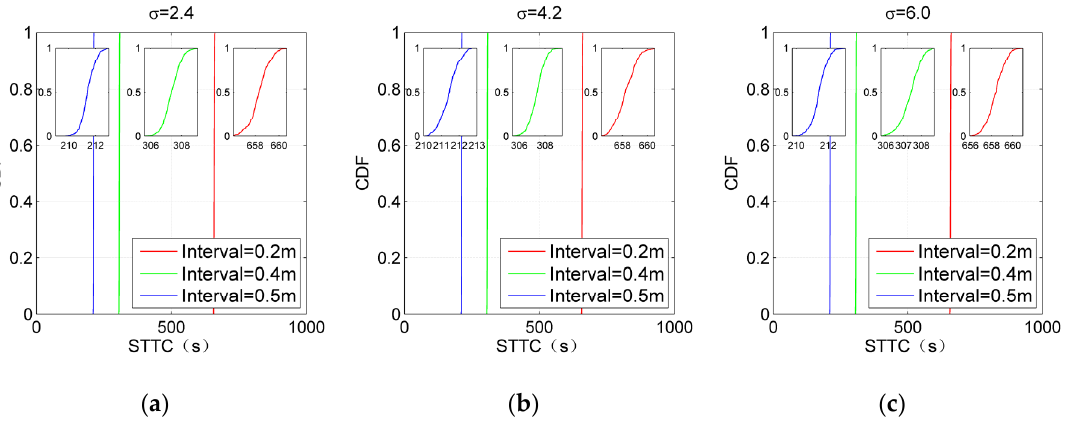
Figure 13. Single total time consumption (STTC) of IKULDAS under various reference tag densities and σ . ( a ) σ = 2.4. ( b ) σ = 4.2. ( c ) σ = 6.